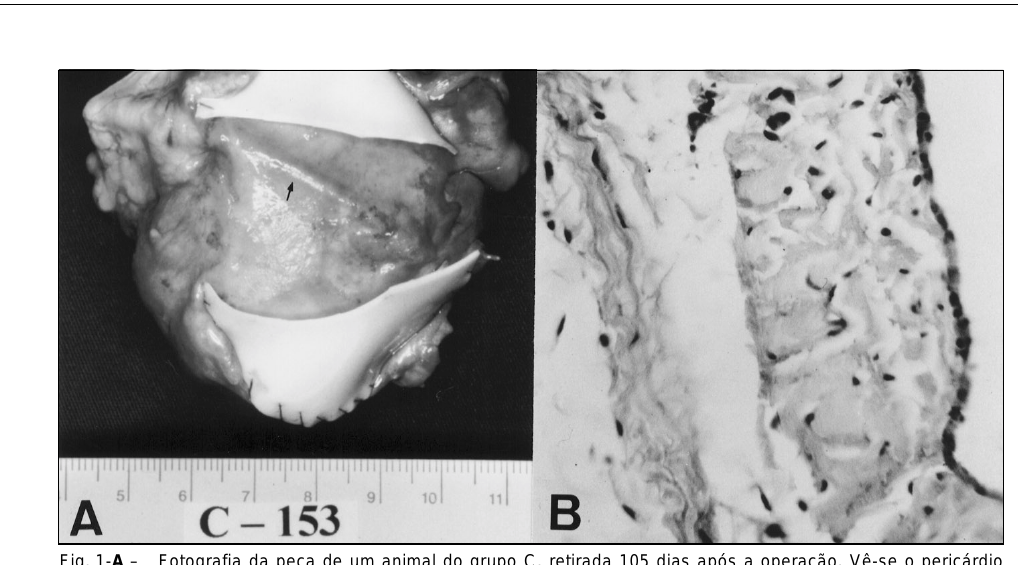
Fig. 1- A – Fotografia da peça de um animal do grupo C, retirada 105 dias após a operação. Vê-se o pericárdio regenerado sob a membrana de látex natural, parcialmente removida. Um cateter insinuado entre o epicárdio e o neoepicárdio (seta) comprova a separação das duas membranas. O número do animal é o do biotério. B – Fotomicrografia do pericárdio neoformado, observando-se, à direita, o revestimento mesotelial e, no restante, o tecido de sustentação formado por conjuntivo denso, colagenizado. H-E x